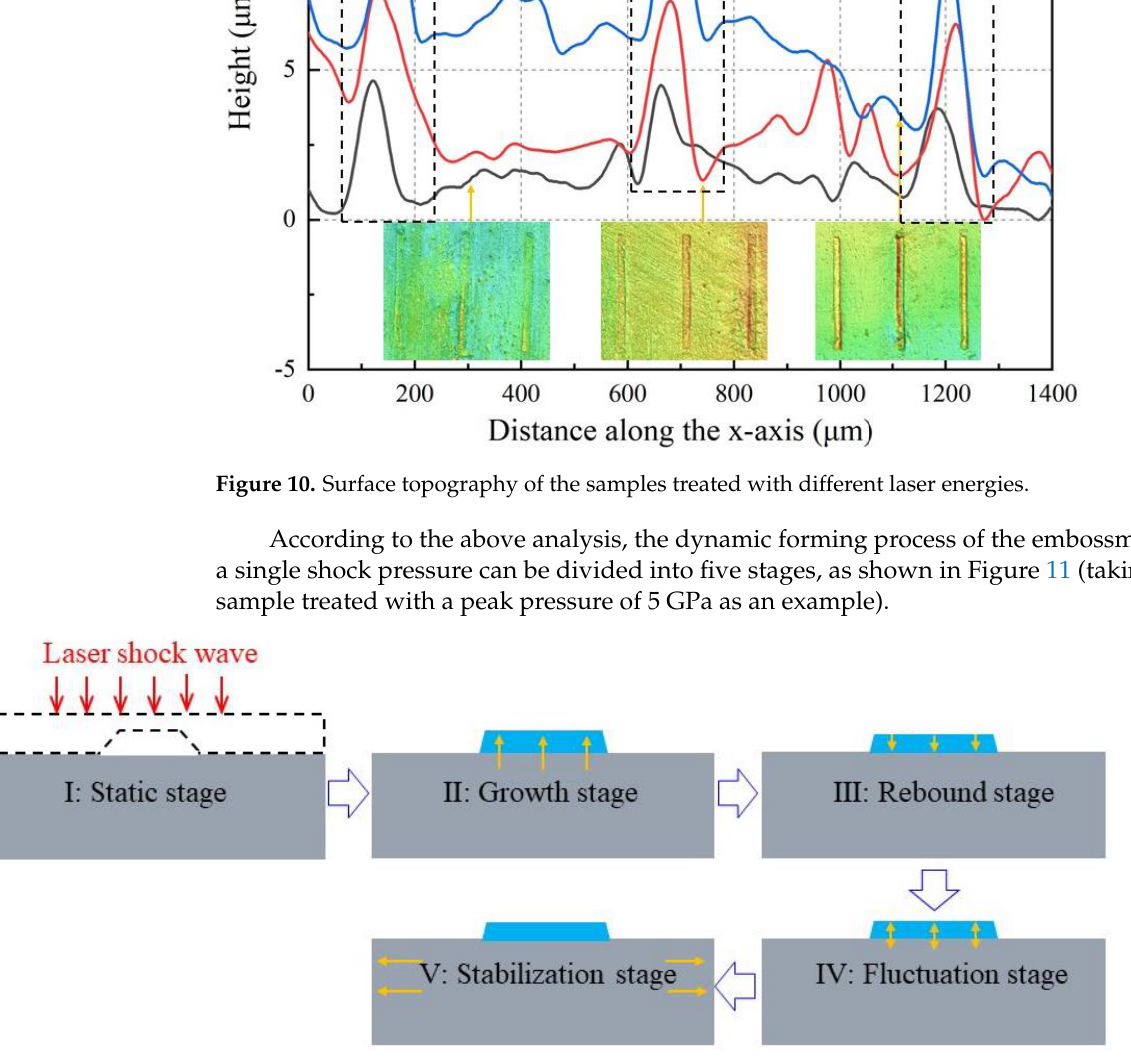
Figure 11. Schematic of the embossment forming process on the sample surface subjected to LSI treatment.